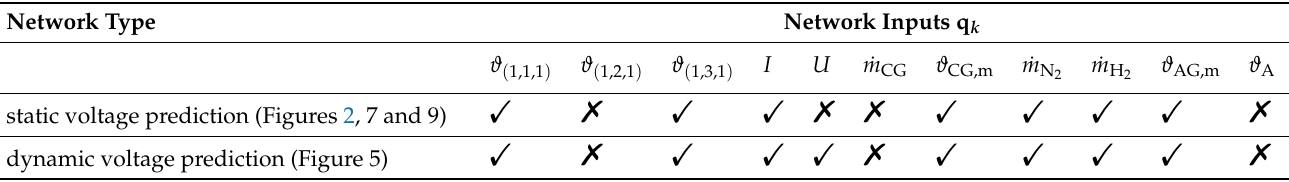
≈ 5.1 · 10 − 4 kg = const. The indices AG and CG denote the s 2